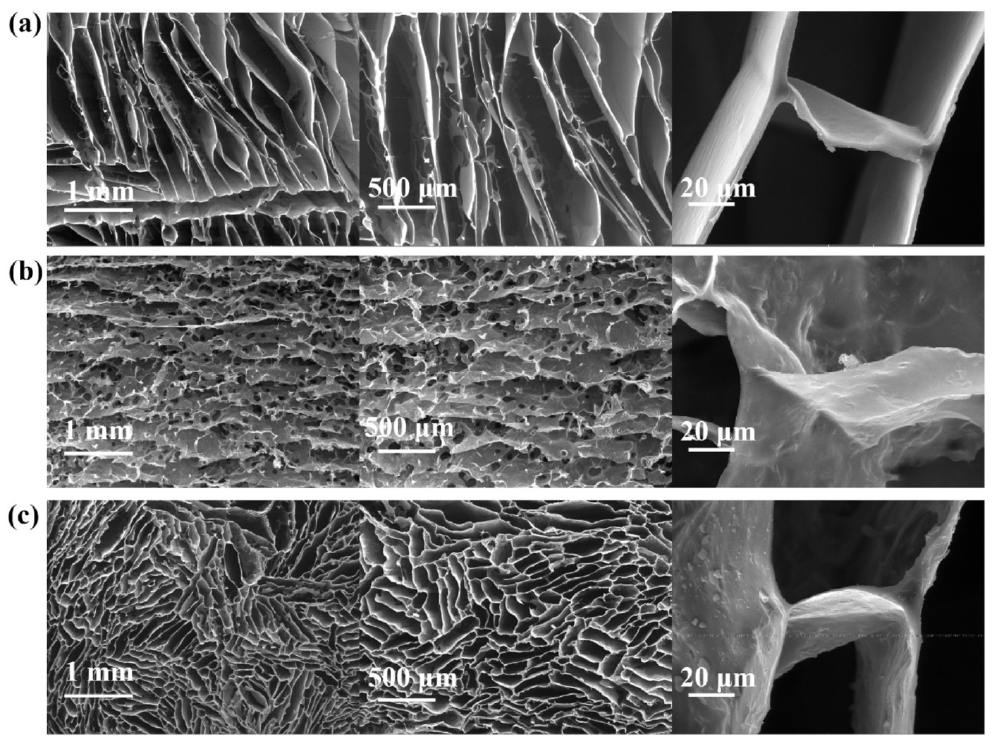
Figure 7. SEM images with different magnification of CS ( a ), GO/CS ( b ) and rGO/CS-Si aerogel ( c ). Reproduced with permission from [13], ©2020 Elsevier B.V.